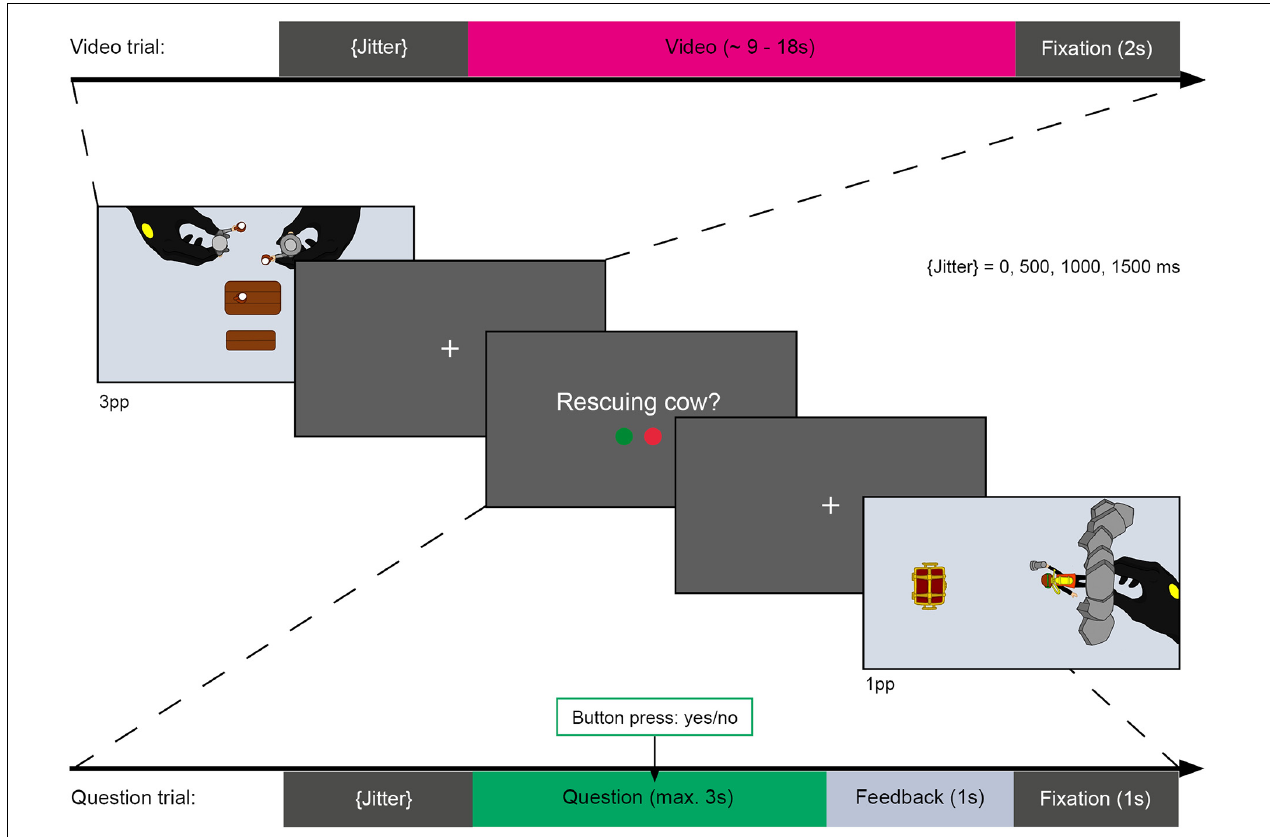
FIGURE 4 | Schematic illustration of task during fMRI session. Top bar showing duration and sequence of a video trial. Video trials contained a variable jitter (0, 500, 1000, or 1500 ms of fixation), a video showing a PLAYMOBIL R (cid:13) story (approx. 9 – 18 s) and a second fixation cross (2 s) serving as an interstimulus interval (ISI). Video trials were presented from an allocentric perspective (3pp, first image) or an egocentric perspective (1pp, last image). After some of the videos, a question regarding the action shown in the preceding video was presented. Question trials consisted of a variable jitter, a question presentation (max. 3 s or terminated by response) and an ISI, containing a 1 s feedback presentation (“correct,” “incorrect,” or “too slow”) and a 1 s fixation cross. Participants had to respond by accepting (right index finger) or rejecting (right middle finger) the presented action description via a response box.